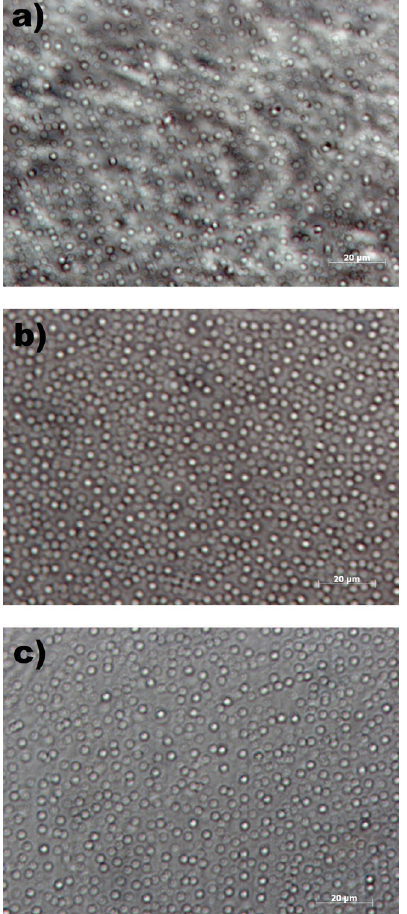
FIGURE 3 - Optical microscopy with transmitted light and 1000x magnification for formulations A, B and C.